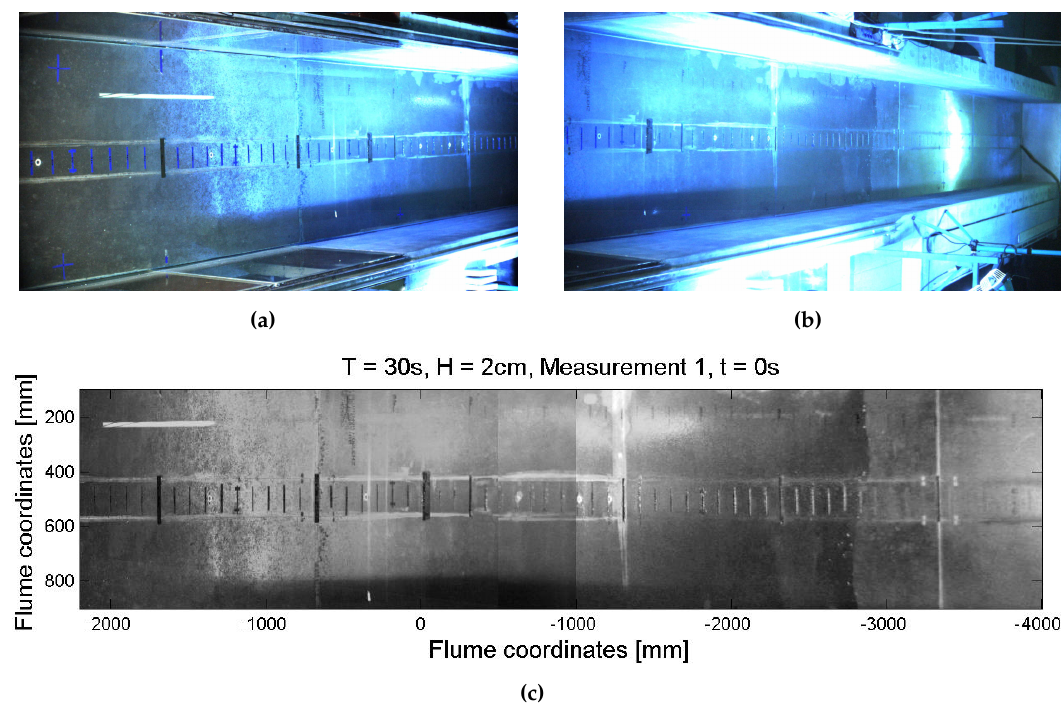
Figure 3. Stages of the image processing with raw data images and final result after image processing routines. ( a ) First camera scene; ( b ) Second camera scene; ( c ) Final stitched image for